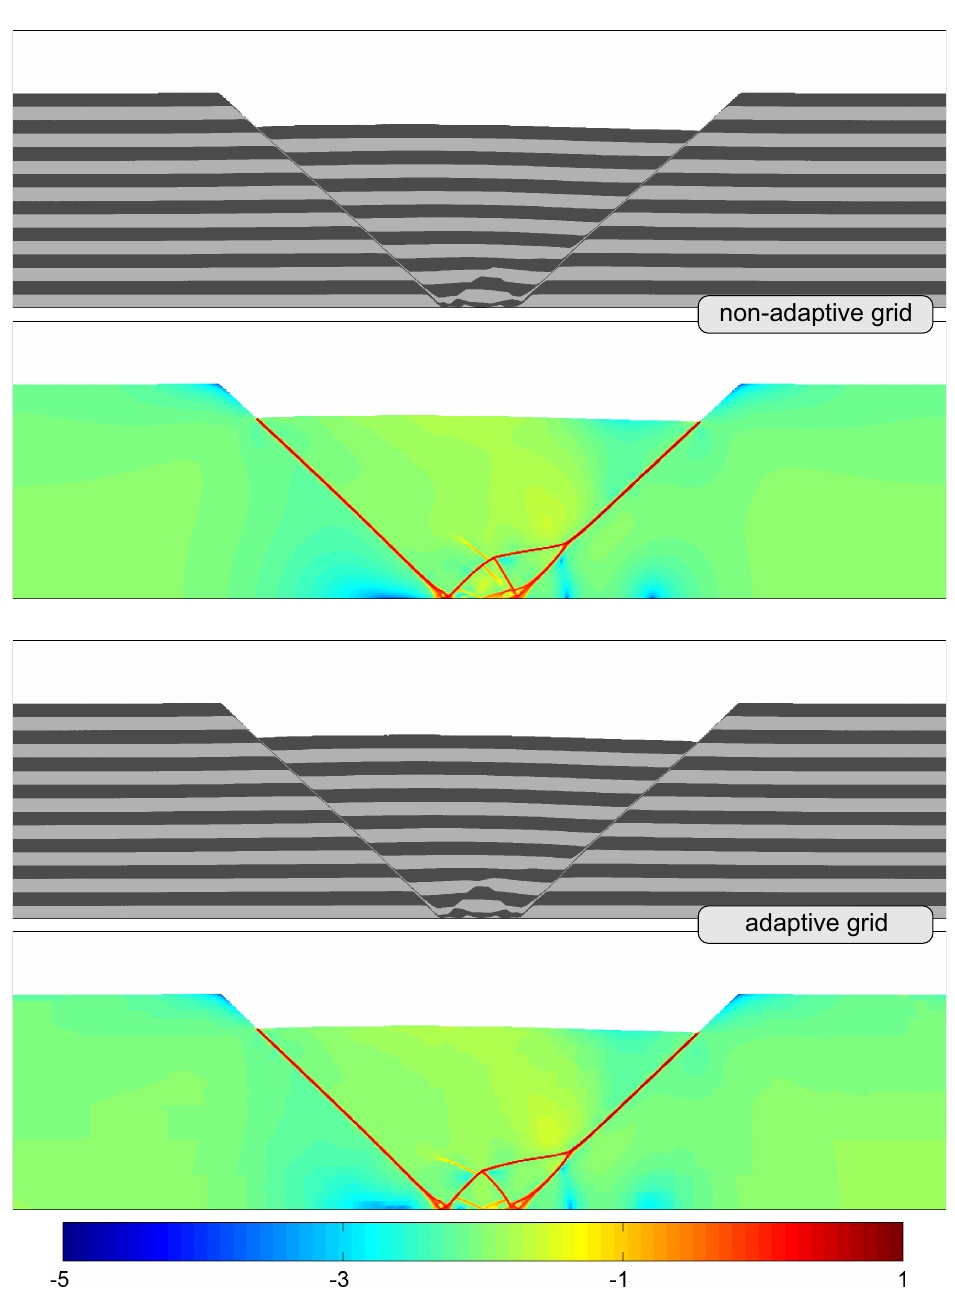
Figure 24. Material fields and log ( ˙ ε II ) plots obtained with non-adaptive and adaptive grids for extension model with φ = 0 ◦ after 12.33%